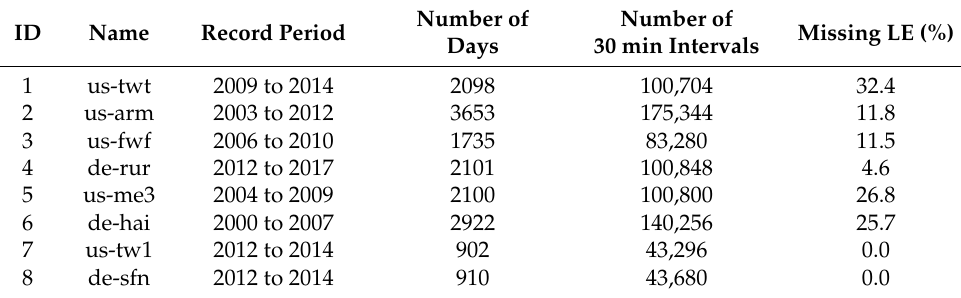
Table 1. Percentage of missing latent heat flux (LE) values for each